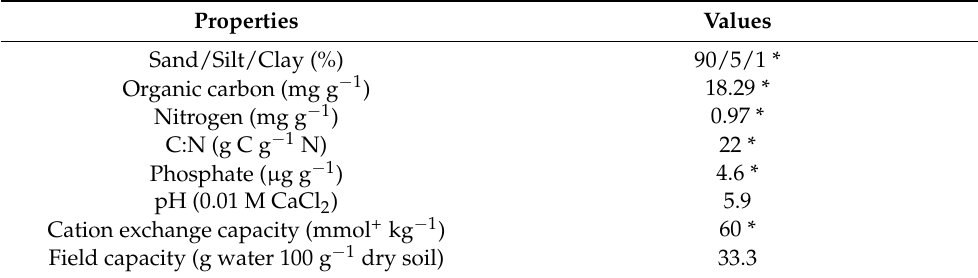
Table 1. Properties of soil.